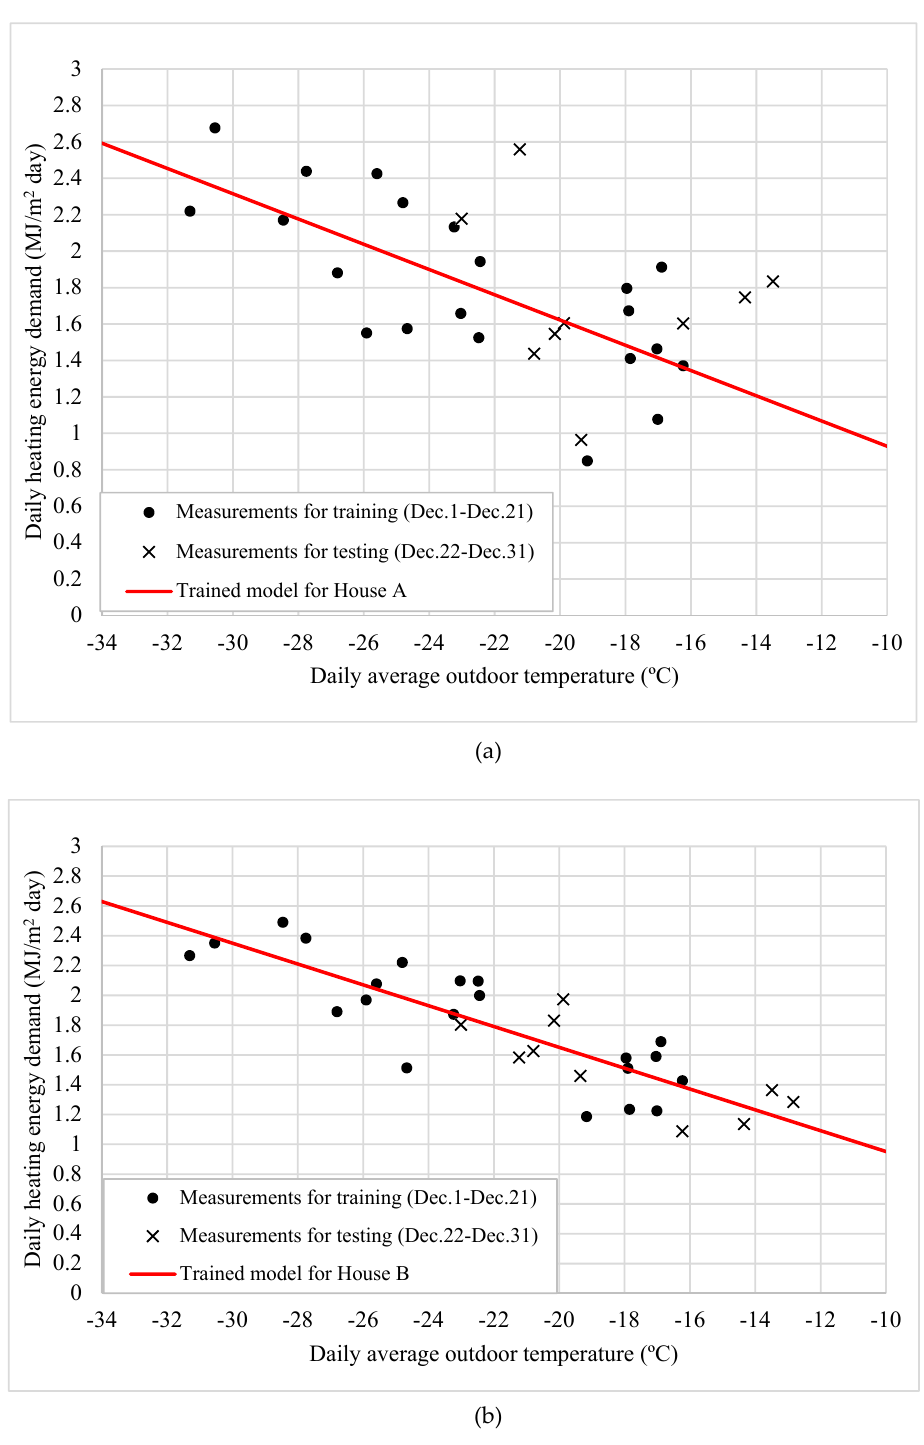
Figure 1. Daily signature of space total heating energy demand used as the benchmarking model from the training data set of December 1–21, 2014: (a) house A and (b) house B.